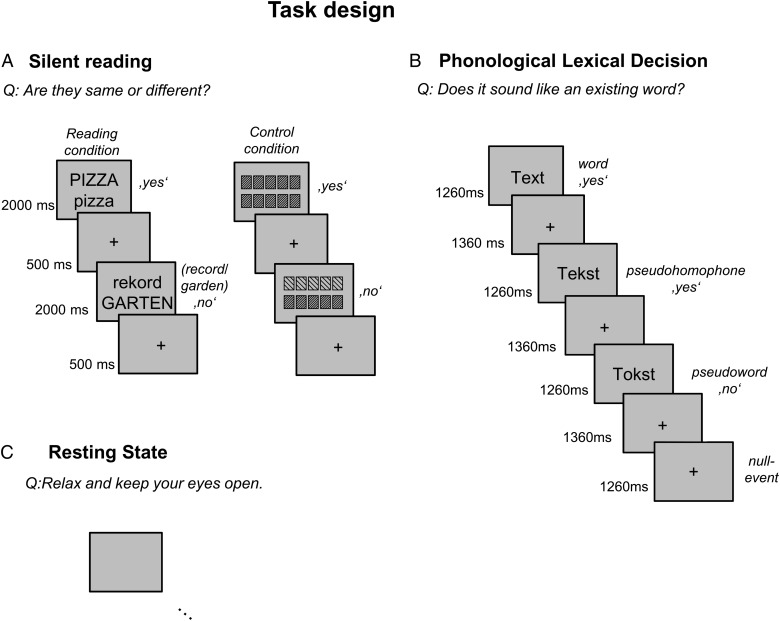
Illustration of the trials presented in the reading-related tasks and during rest. (A) Trials from the reading condition (left) and the control condition (right) of the silent reading task. (B) Trials for words, pseudohomophones and pseudowords, as well as a null event in the phonological lexical decision task. (C) During rest, a blank screen was presented, and participants were asked to relax and keep their eyes open.